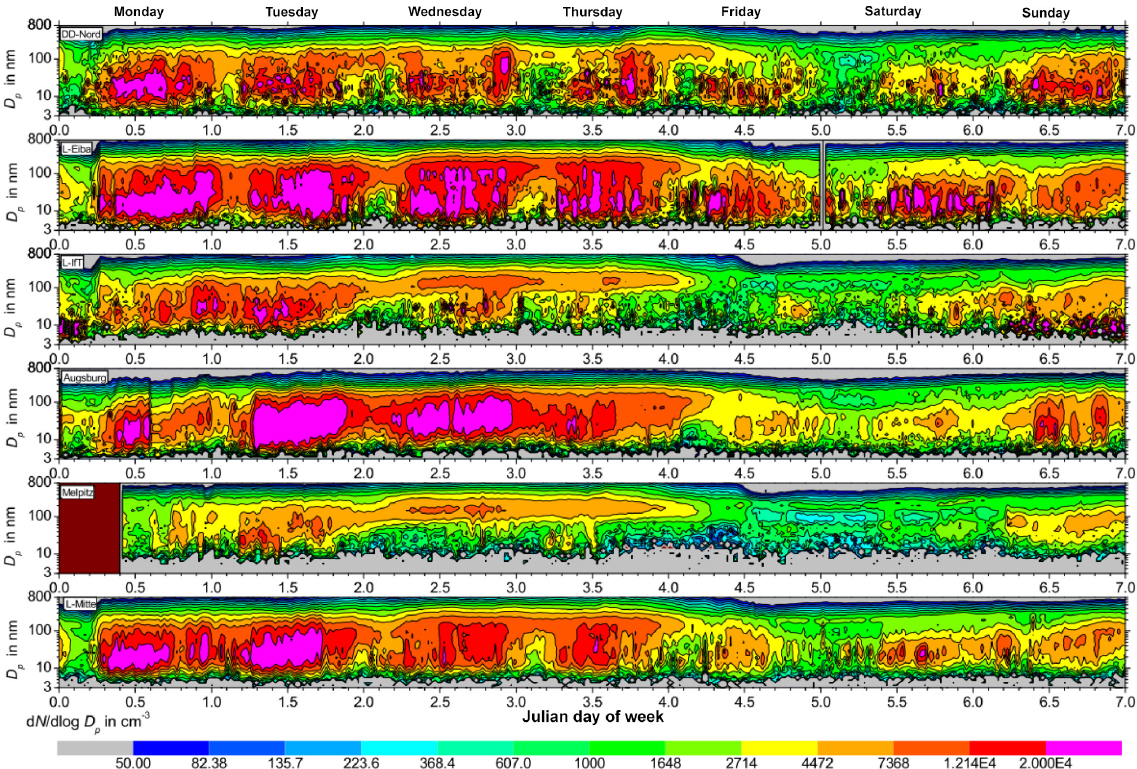
Figure 3. Exemplary contour diagrams of particle number size distributions at six mainly urban GUAN sites (20–26 December 2009). Such diagrams assist the visual quality control of the